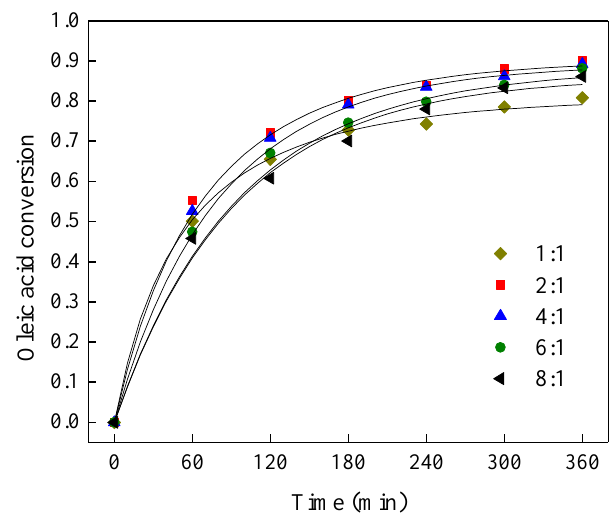
Figure 2. Influence of molar ratio of ethanol to oleic acid on esterification reaction. Reactions occurred at a temperature of 433 K and with microwave power of 150 W.